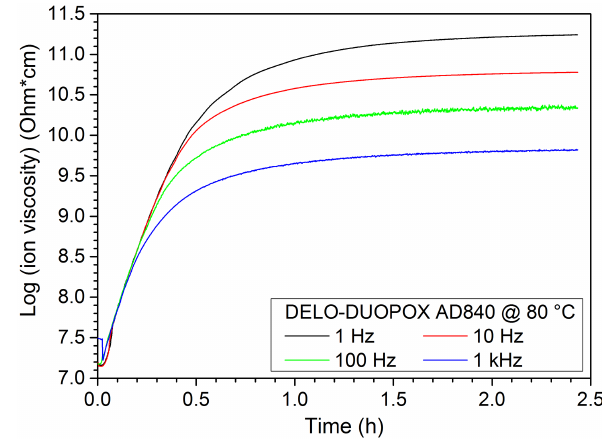
Figure 11. Depth profiles of PE-Xc samples with different degrees of cross-linking measured in the center.